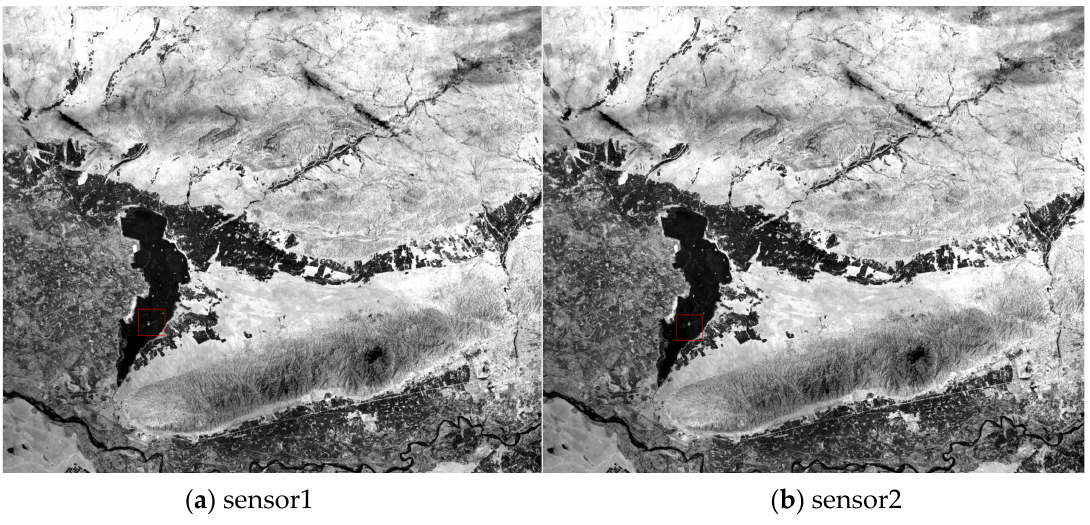
Figure 13. Thermal infrared image data for the Ulansuhai Nur experimental area (13 July 2022), including fitting results for ( a ) 20220710 and ( b ) 20220713 calibration coefficients. Table 2. ZY1-02E and thermal IR camera parameters.